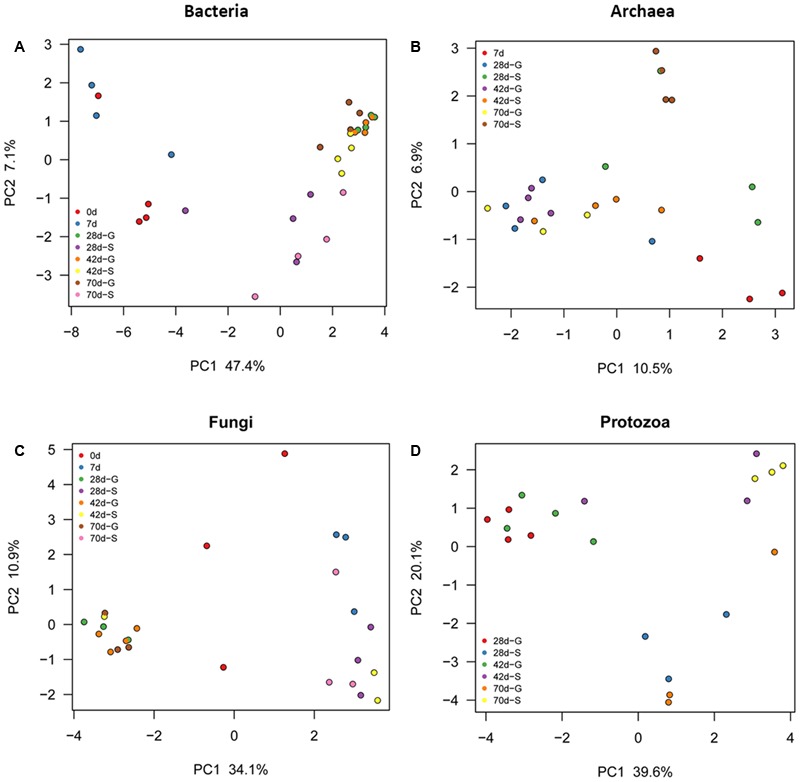
Principal coordinate analysis (PCoA) of each ruminal microbial domain in S and G kids at different ages. (A) Bacteria, (B) Archaea, and (C) Fungi, and (D) Protozoa.